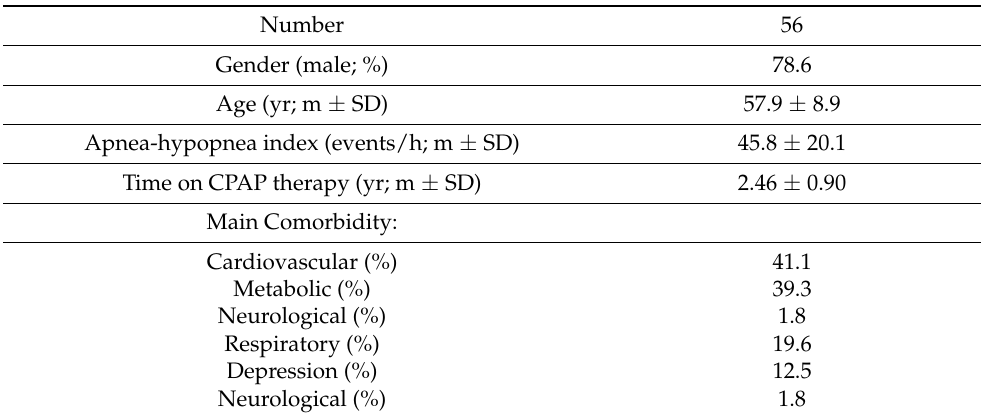
Figure 1. Flow chart of the study. Table 1. Patient